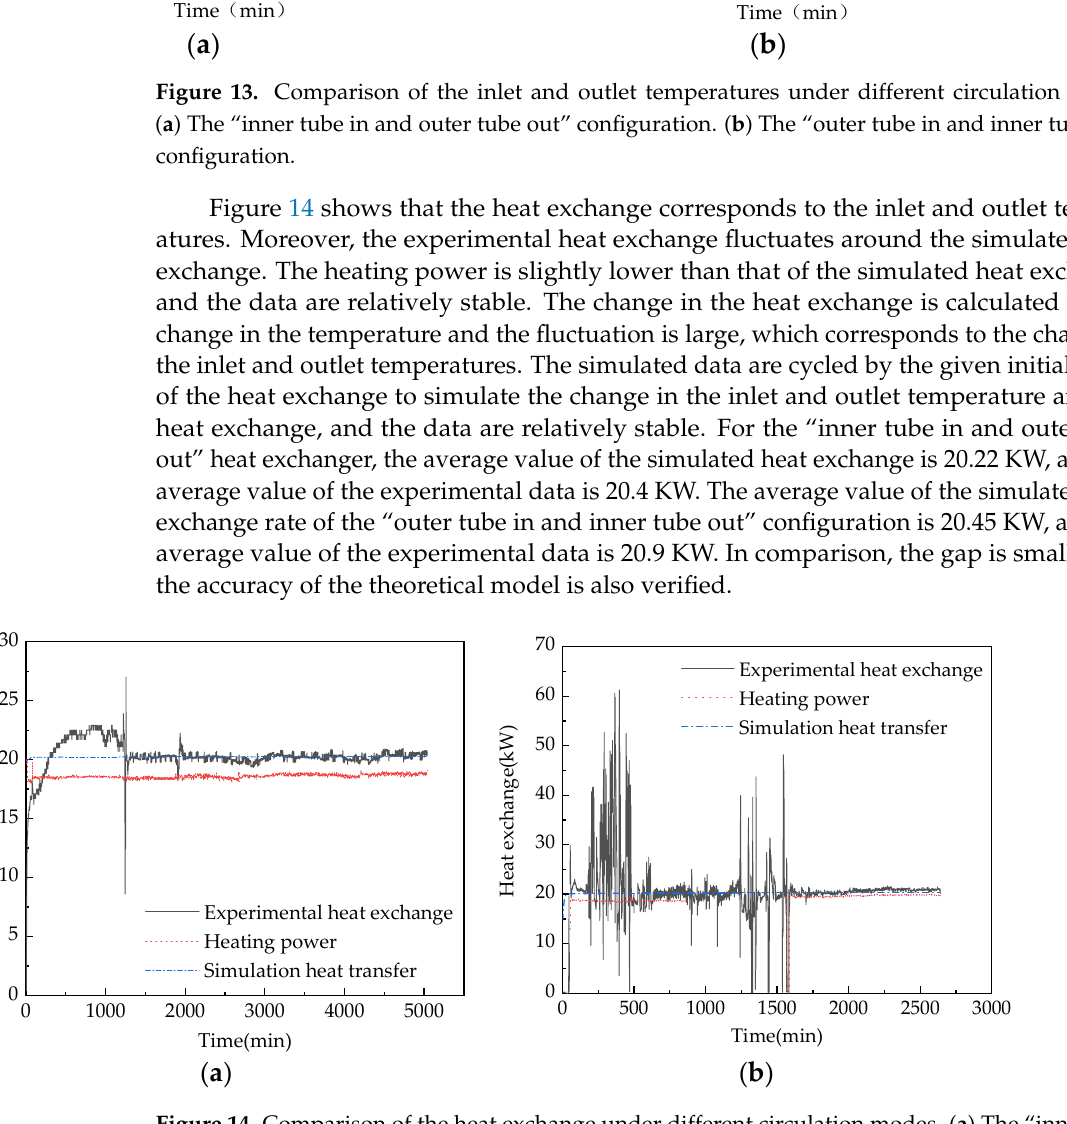
Figure 14. Comparison of the heat exchange under different circulation modes. ( a ) The “inner tube in and outer tube out” configuration. ( b ) The “outer tube in and inner tube out” configuration.